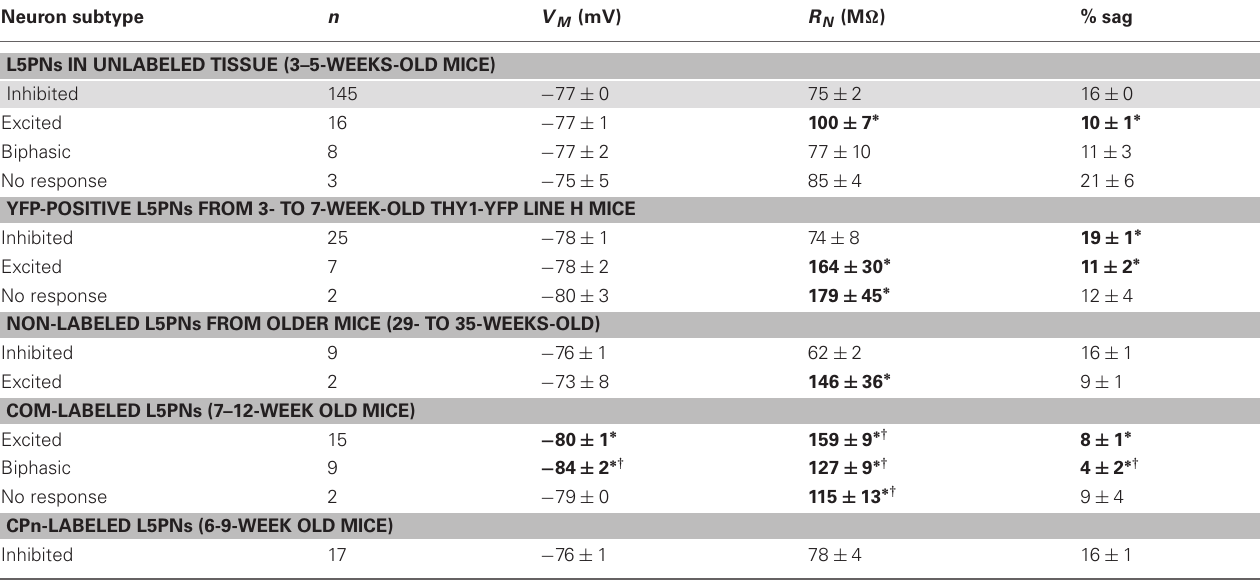
Table 1 | Physiology and serotonergic responsiveness of L5PN subpopulations. Neuron